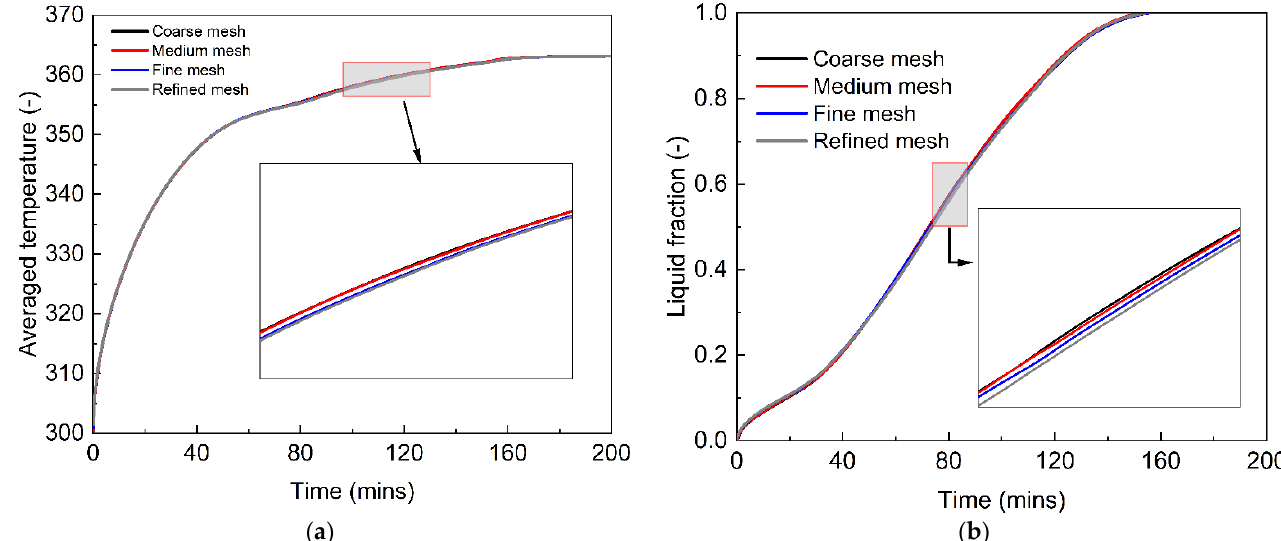
Figure 3. Effect of grid density on the computational results of the melting process of phase change materials. ( a ) Average temperature; ( b ) Liquid fraction.